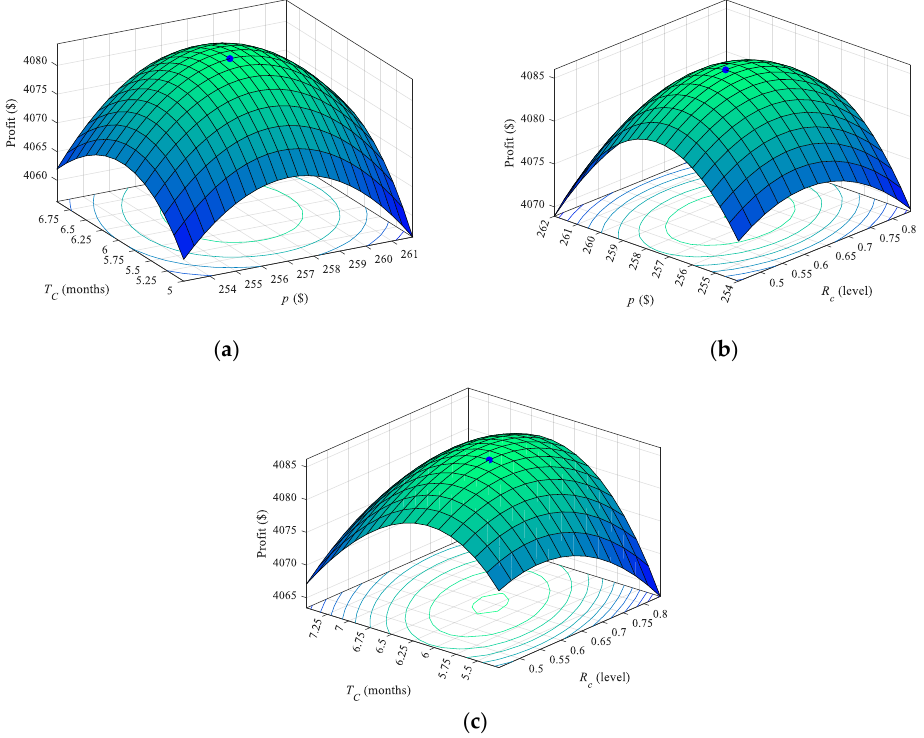
Figure 7. Profit function ( τ ) with regard to: ( a ) the selling price ( p ) and cycle time ( T C ); ( b ) the manufacturer’s carbon emission reduction level ( R c ) and selling price ( p ); ( c ) the manufacturer’s carbon emission reduction level ( R c ) and cycle time ( T C